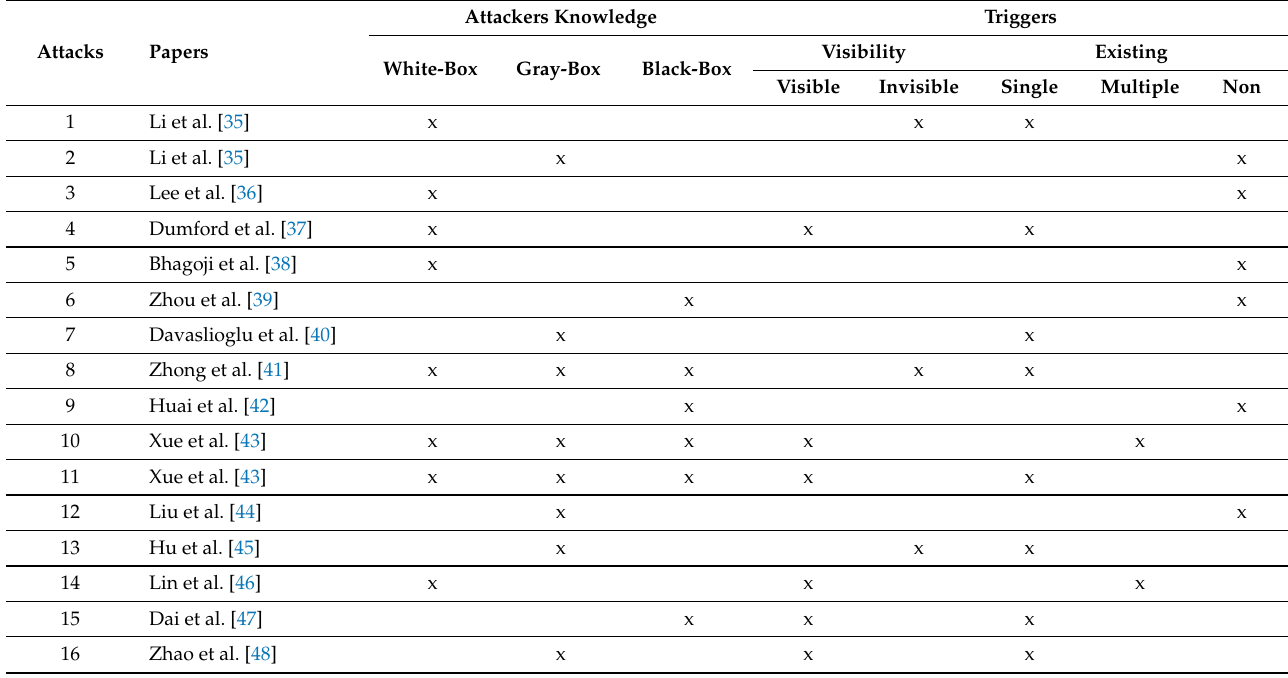
Table 5. A summary of attackers’ knowledge and triggers for each